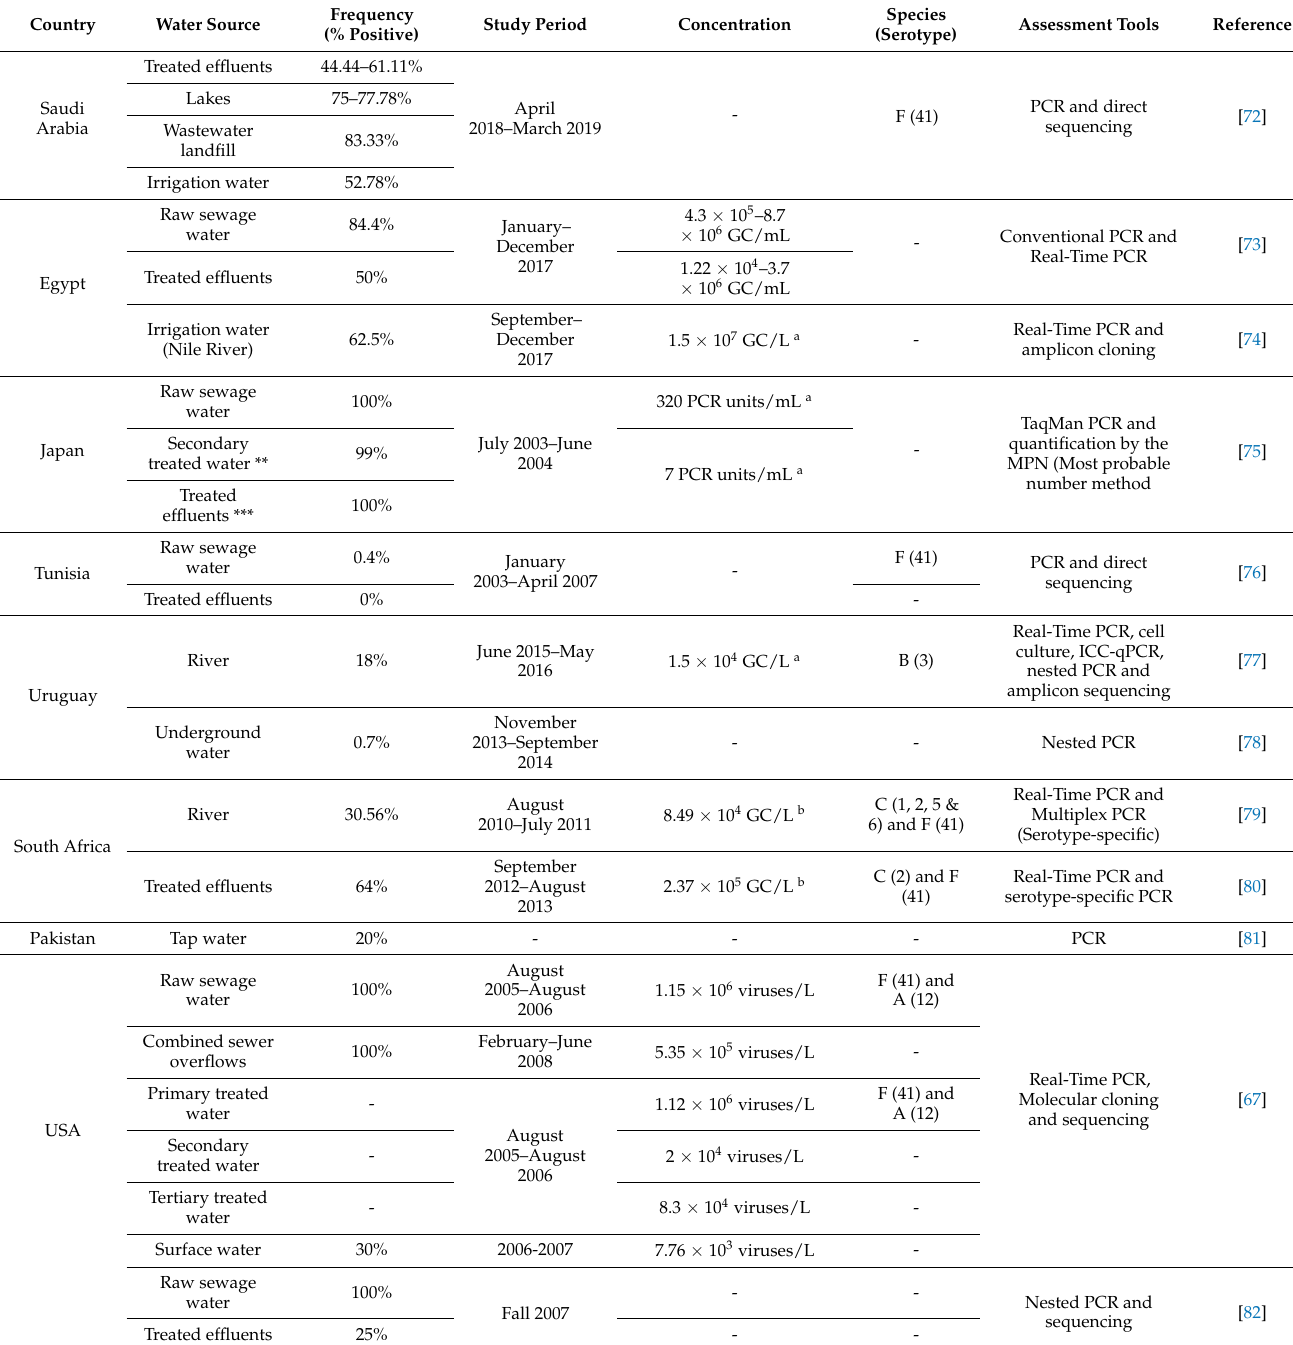
Table 1. Occurrence of adenovirus in various water